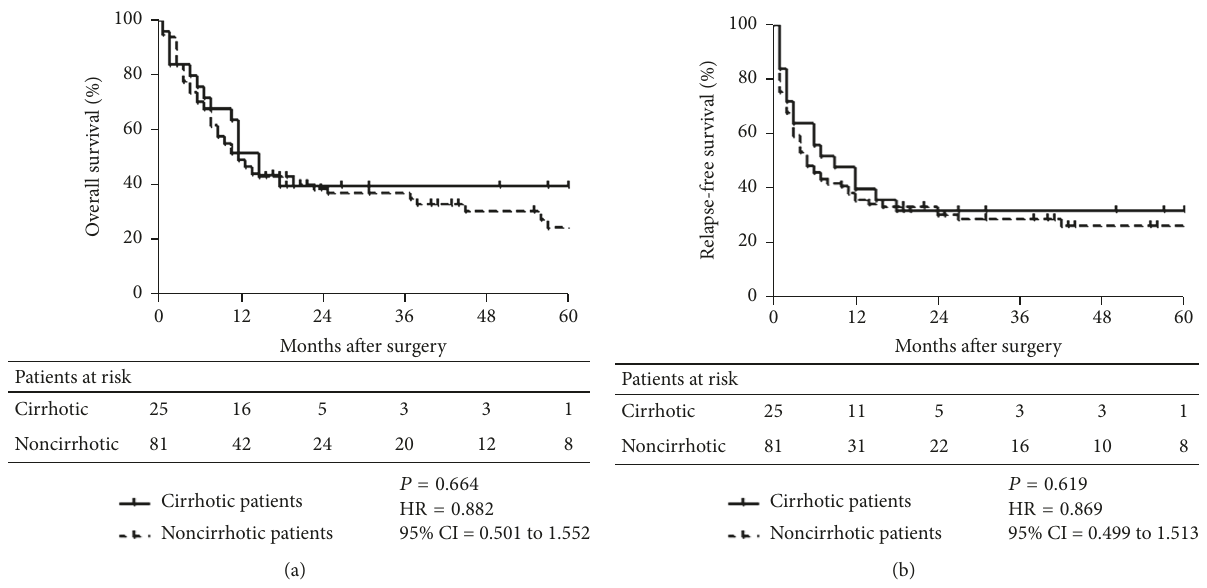
Figure 1: Survival outcomes of the patients with and without cirrhosis. Shown are the impact of cirrhosis on the OS (Panel (a)) and RFS (Panel (b)) of the entire cohort. The data revealed that the presence of cirrhosis showed no association with the OS (HR, 0.882; 95% CI, 0.501 to 1.552; 𝑃 = 0.664 ) and RFS (HR, 0.869; 95% CI, 0.499 to 1.513; 𝑃 = 0.619 ) of the